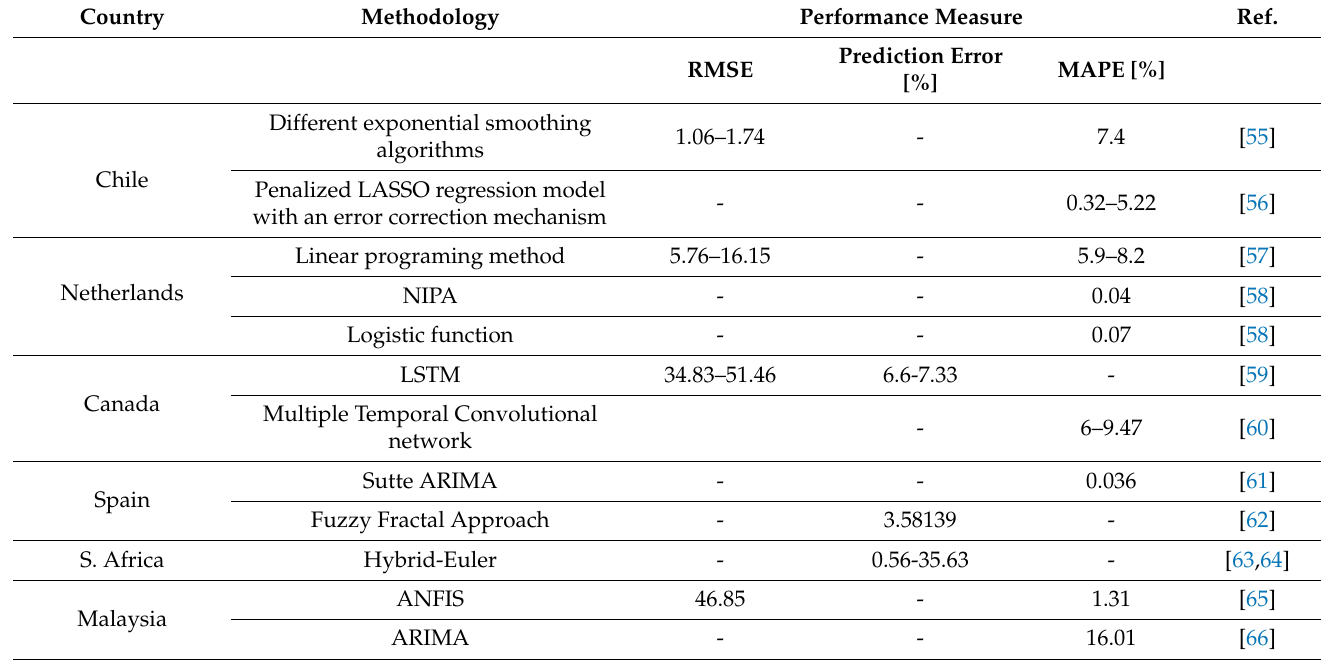
Table 4. Systematization of the current state-of-the-art COVID-19 related forecasting solutions, and their reported performance measures for six analyzed